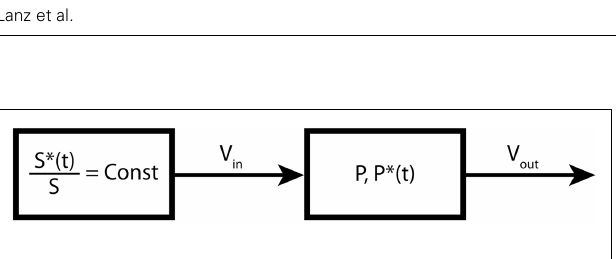
FIGURE 2 | One-product pool model . In this example, the substrate pool is forced to maintain a constant fractional